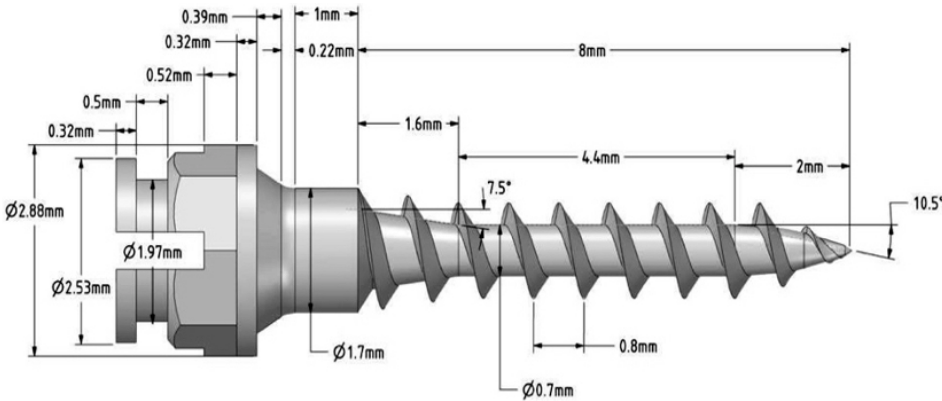
Figure 1. Three-dimensional rendering of the custom-made mini-implant design.